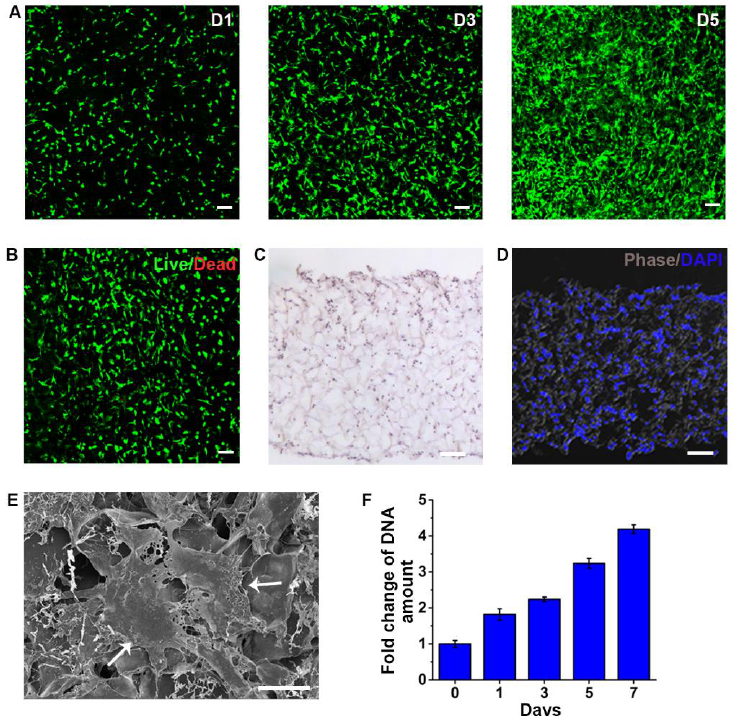
Figure 2. Proliferation of SKPs in the C-GAG matrix. ( A ) SKPs expressing GFP in a C-GAG matrixes after culture for 1 (left), 3 (middle), and 5 (right) days, respectively. ( B ) Cell viability. Live/dead staining of the SKPs after incubation for 3 days. ( C , D ) SKPs distribution in C-GAG. After incubation for 10 days, the C-GAG matrixes with SKPs were sectioned and analyzed by HE and DAPI staining. ( E ) The SKPs ’ morphology and their interactions with the matrix was assessed by SEM analysis after culturing for 10 days. Arrows: SKPs. ( F ) SKPs ’ growth. The numbers of cells in the C-GAG matrixes were quantified by measuring the amounts of DNA. Scale bars: 50 μm.